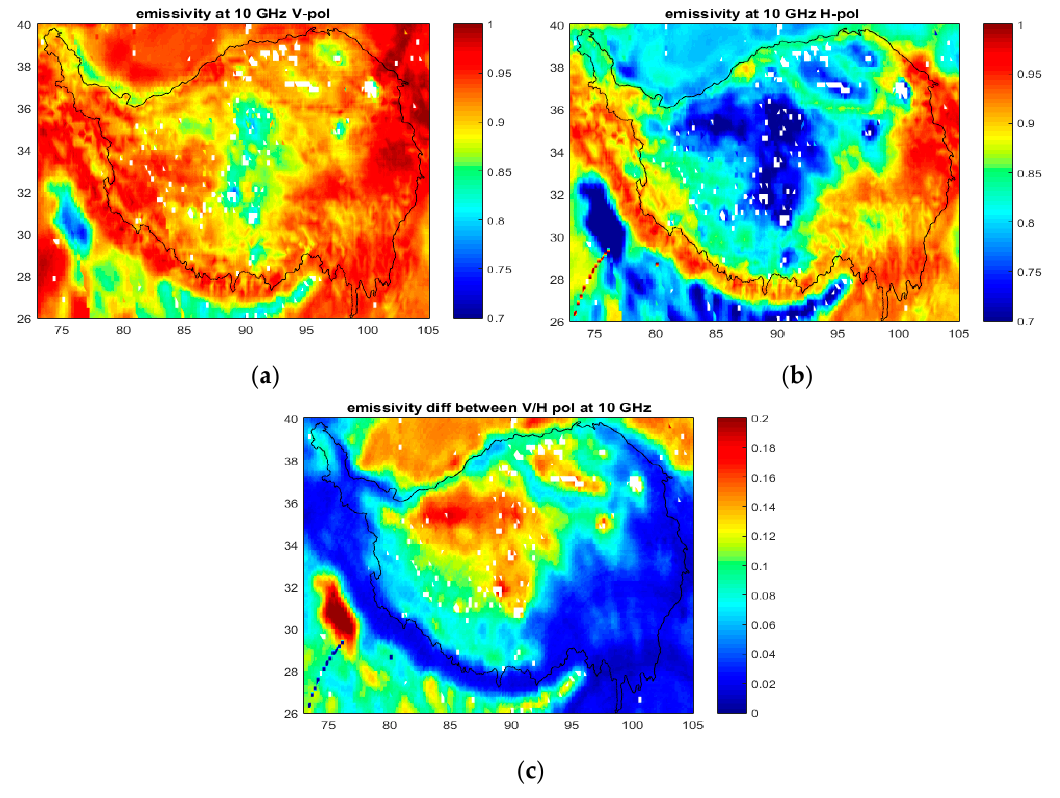
Figure 2. Land surface emissivity and differences between vertical and horizontal polarization at 10.65 GHz: ( a ) vertical polarization; ( b ) horizontal polarization; and ( c ) differences between the two polarizations.